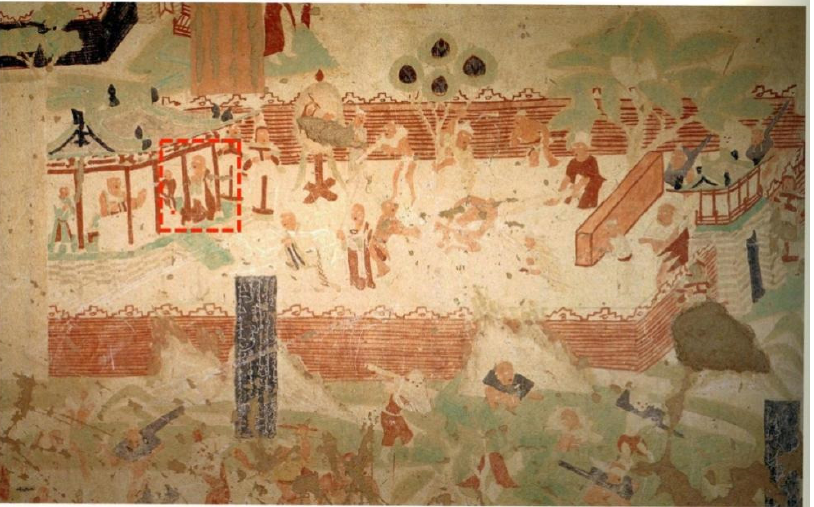
Figure 1. The Hall of King Yama in the Mulian bianxiang . Cave 19 of Yulin, Dunhuang. Five Dynas- ties (Dunhuang Yanjiuyuan 2003, p. 174).